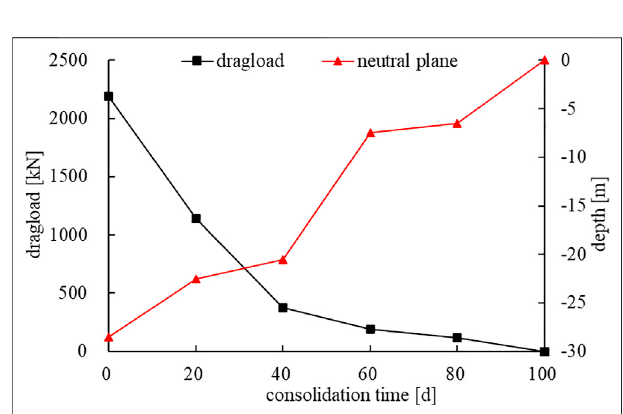
FIGURE7| Developmentofdragloadand neutralplanewithanincrease of the height of back fi lls.